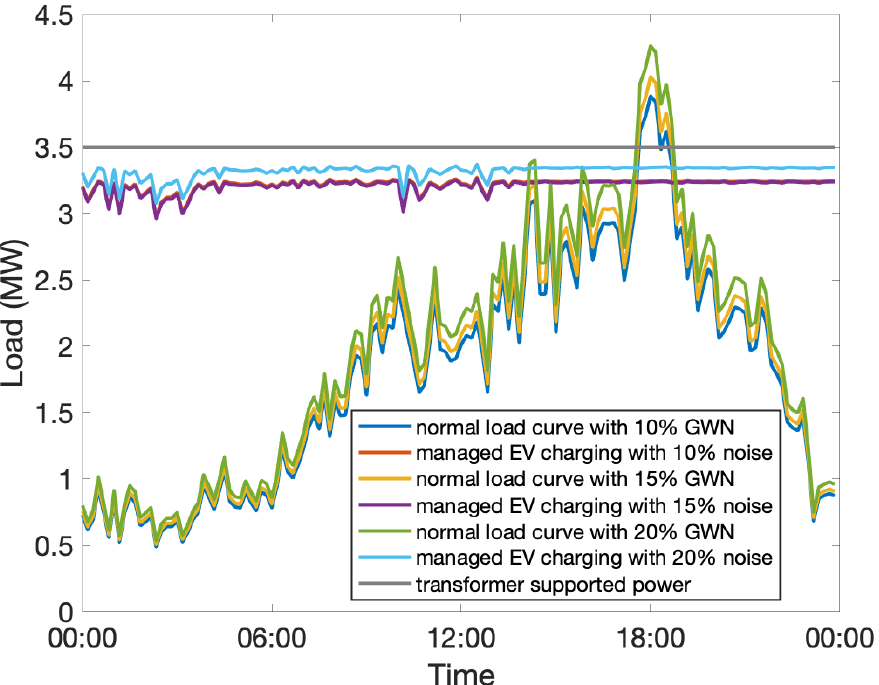
Figure 9. Comparison of load curves of different situations with different percentages of GWN.